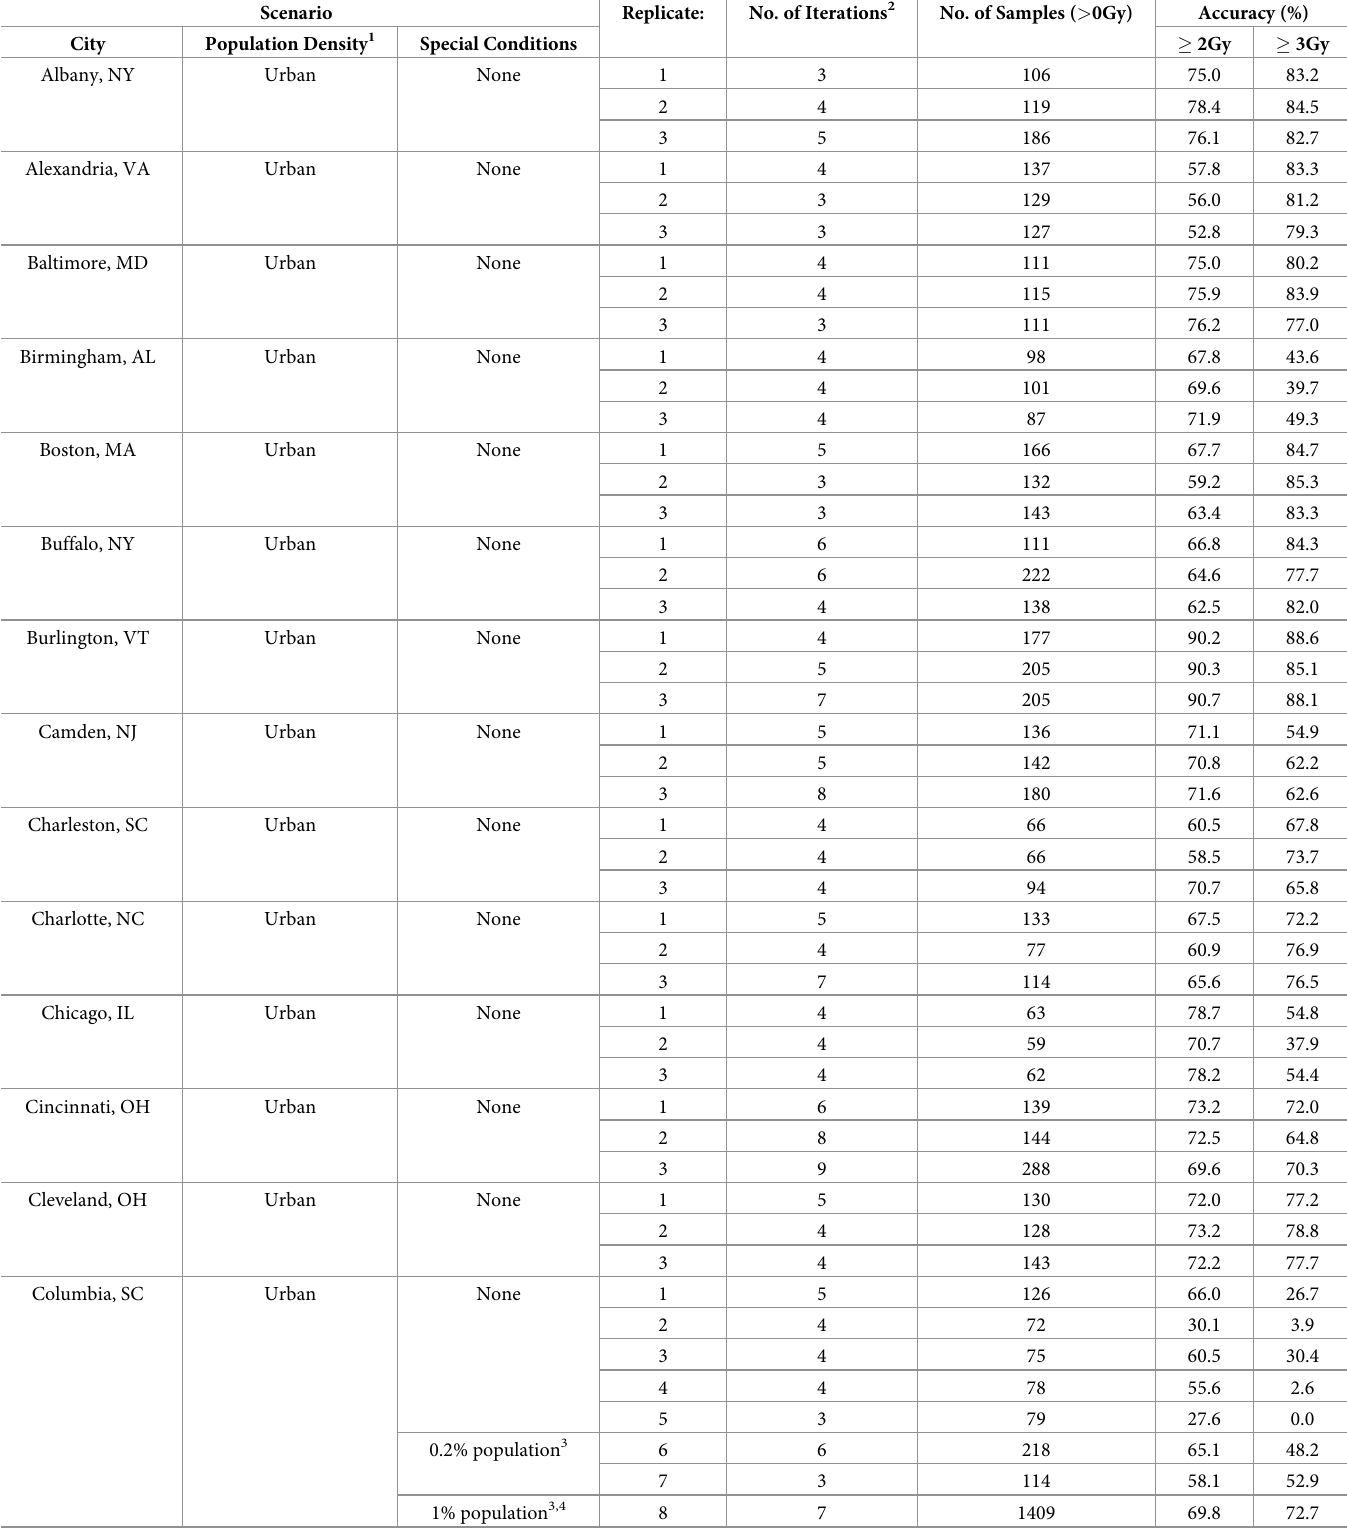
Table 1. Simulated analyses of population-scale nuclear radiation scenarios on 22